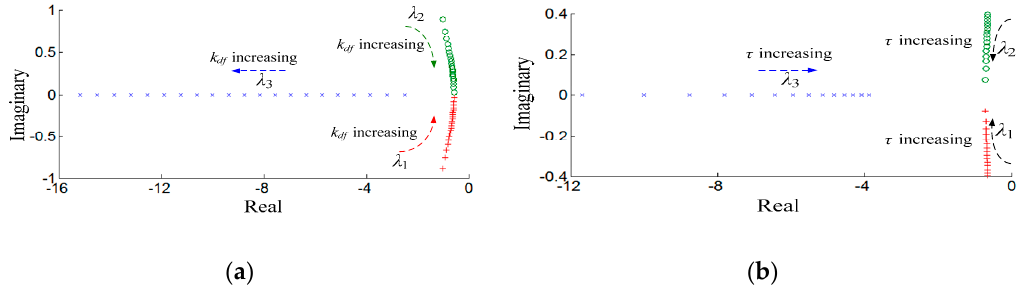
Figure 8. Traces of the three eigenvalues as a function of ( a ) differential feedforward gain: τ = 0.3, 0 ≤ k df ≤ 2; ( b ) filter time gain: k df = 1, 0.1 ≤ τ ≤ 0.96.